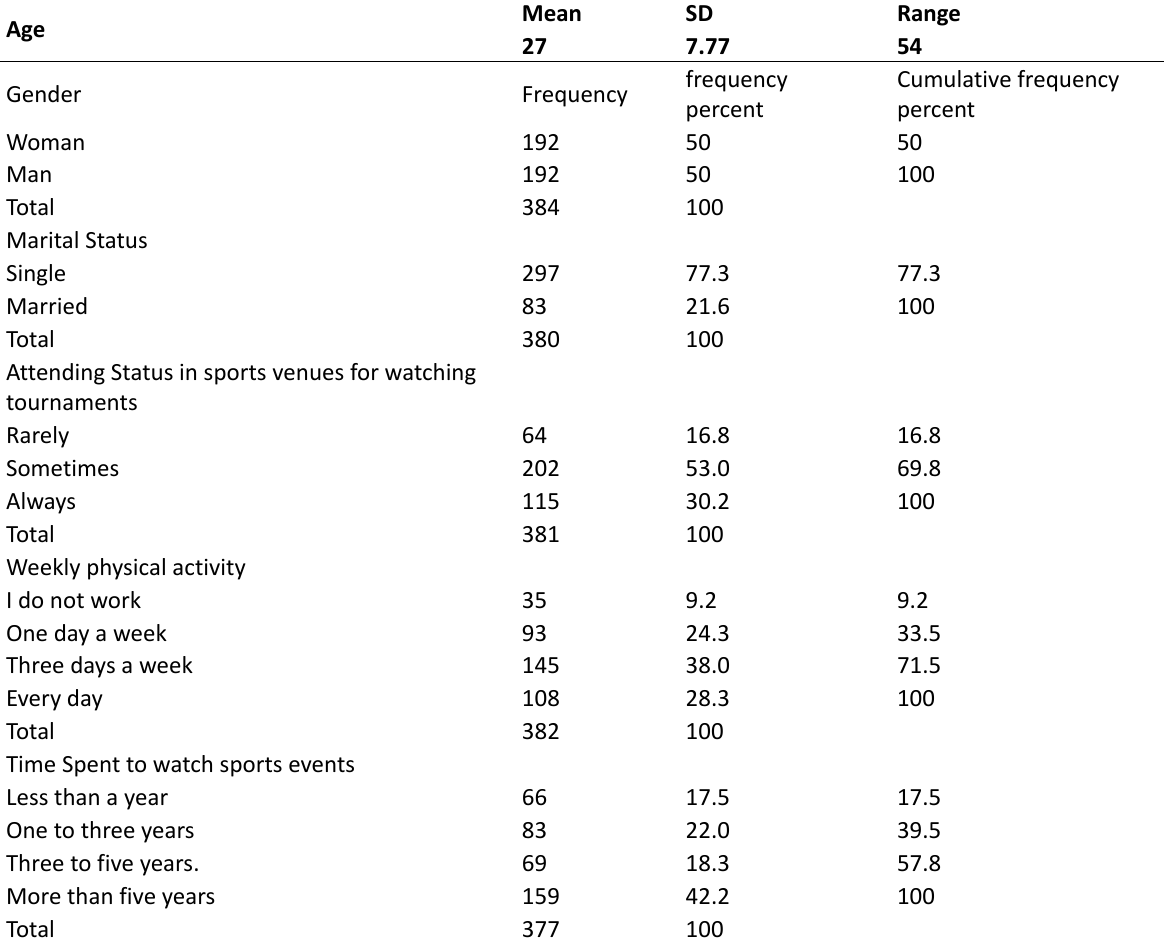
Table 1. Descriptive statistics for the demographic factors